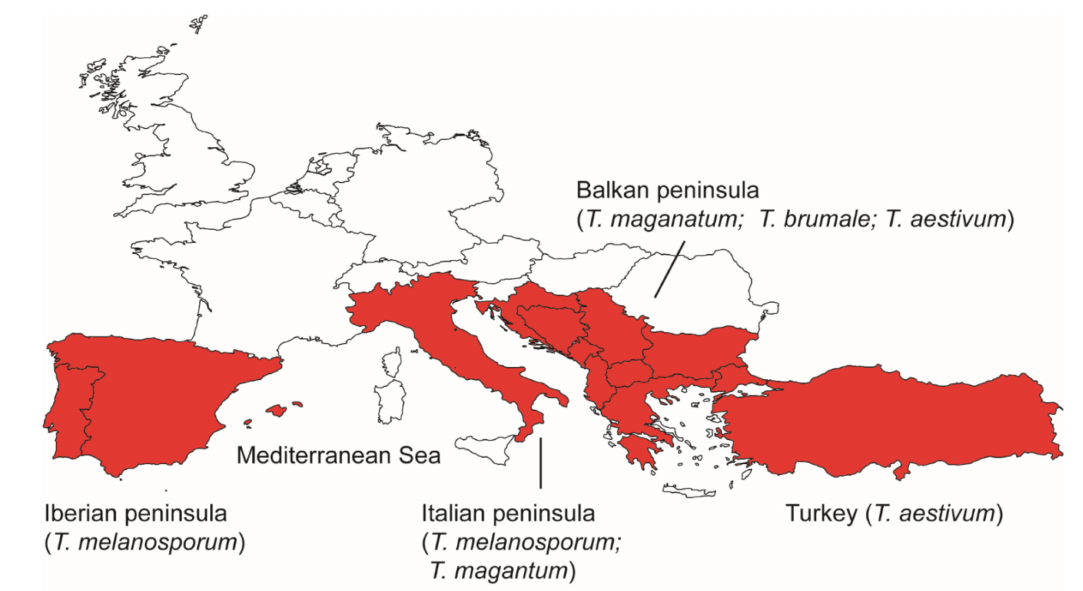
Figure 2. A map showing refugia for different European truffle species during the last glaciation. In southwestern China, T. indicum and T. himalayense are mainly distributed in the “Three Parallel Rivers” region. Population genetics analyses using SNPs from four DNA fragments revealed three major haplotype groups, namely Group W (west), C (central) and N (north), isolated by the paleo-Red River and modern Jinsha River (the upper region of Yangtze River), in T. indicum (Figure 3). This indicates that both paleo and modern drainage systems have contributed to the formation of its genetic structure by acting as physical barriers to gene flows between populations. In contrast, no significant geographic structure was detected in T. himalayense , likely due to the lower evolutionary rates of this species, at least in the DNA fragments used in the population genetics study [3]. In fact, a significant “isolation by rivers” genetic structure could be detected in T. himalayense while using SNPs from the whole genome to infer the phylogeographical structure of this species (author’s unpublished data). Therefore, drainage isolations have served as a key driving factor for the formation of genetic structure in both T. indicum and T. himalayense .